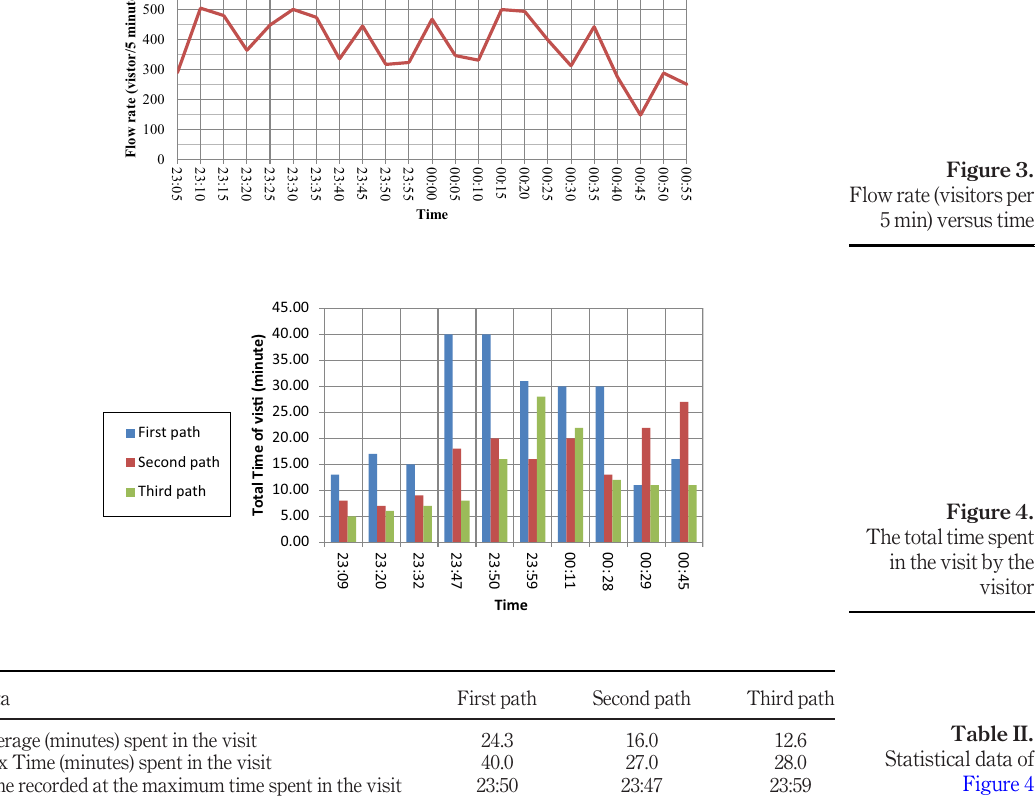
Figure 3. Flow rate (visitors per 5 min) versus